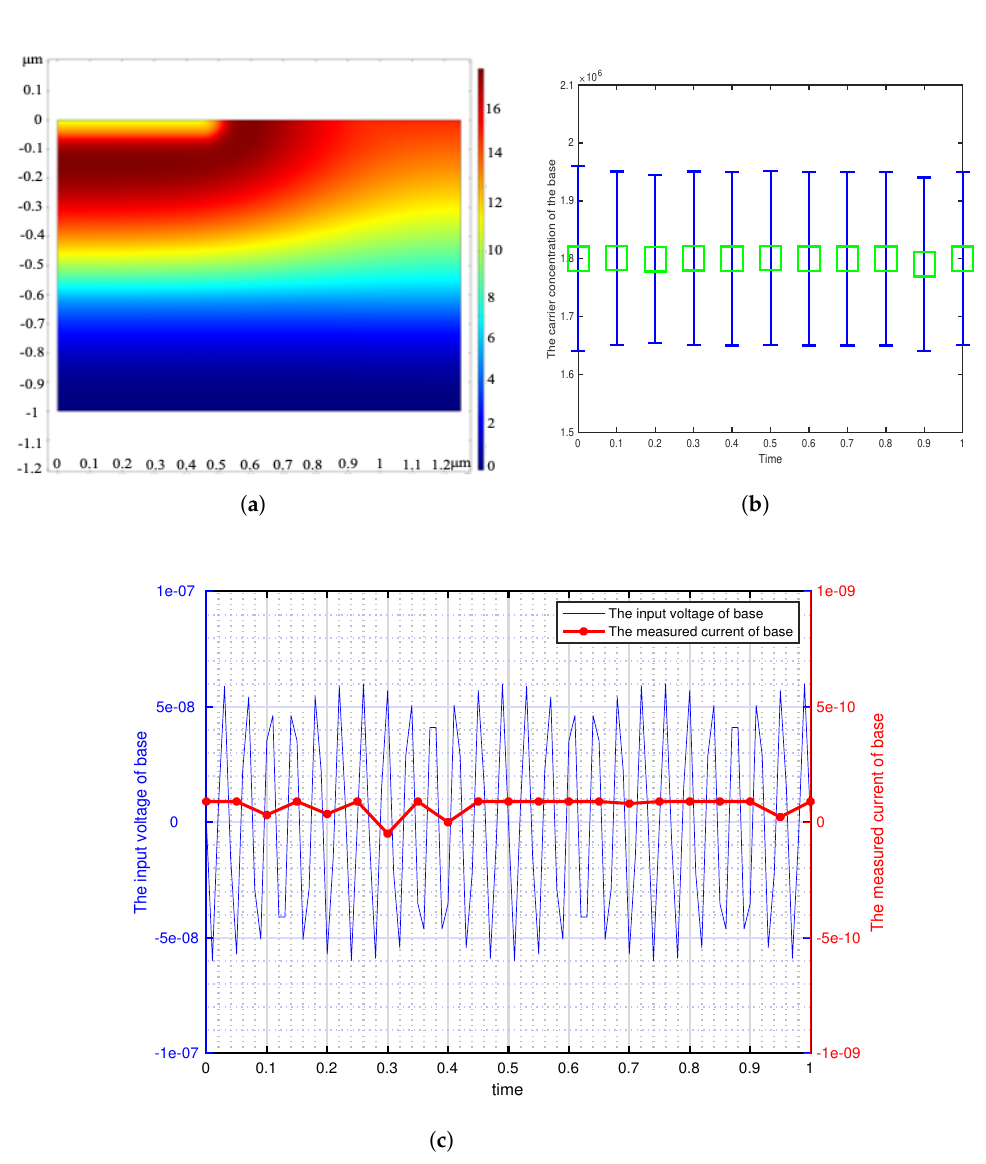
Figure 4. The corresponding sinusoidal voltage signal is applied to the bipolar transistor in the amplification region, which is made of gallium arsenide (GaAs) with doping concentration of 1.8 × 10 6 cm − 3 and carrier lifetime of 10 − 8 s. ( a ) The potential distribution of the intrinsic semi- conductor under sinusoidal small voltage signal. (2-D front view) ( b ) The variation of base carrier concentration with time. ( c ) The input weak sinusoidal voltage signal and corresponding base current